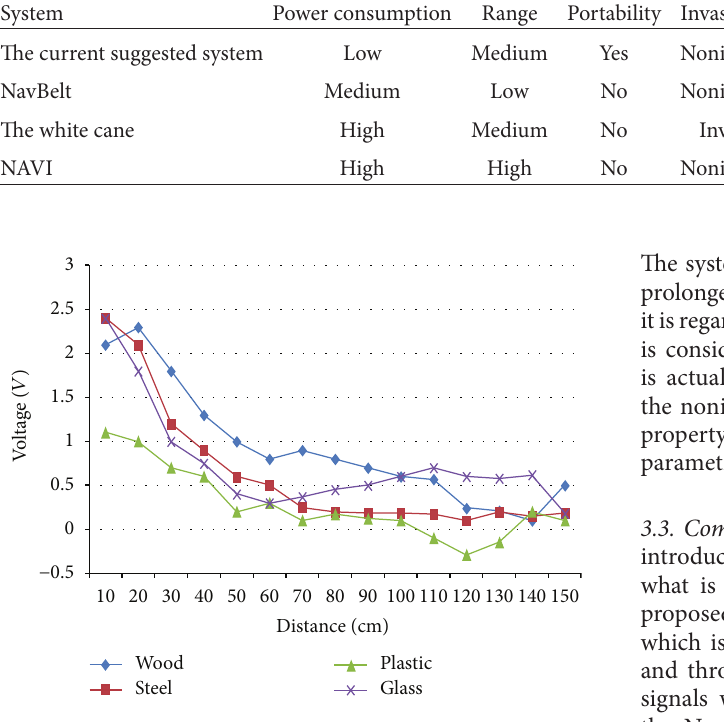
Figure 7: Voltage output at the object distance of different material